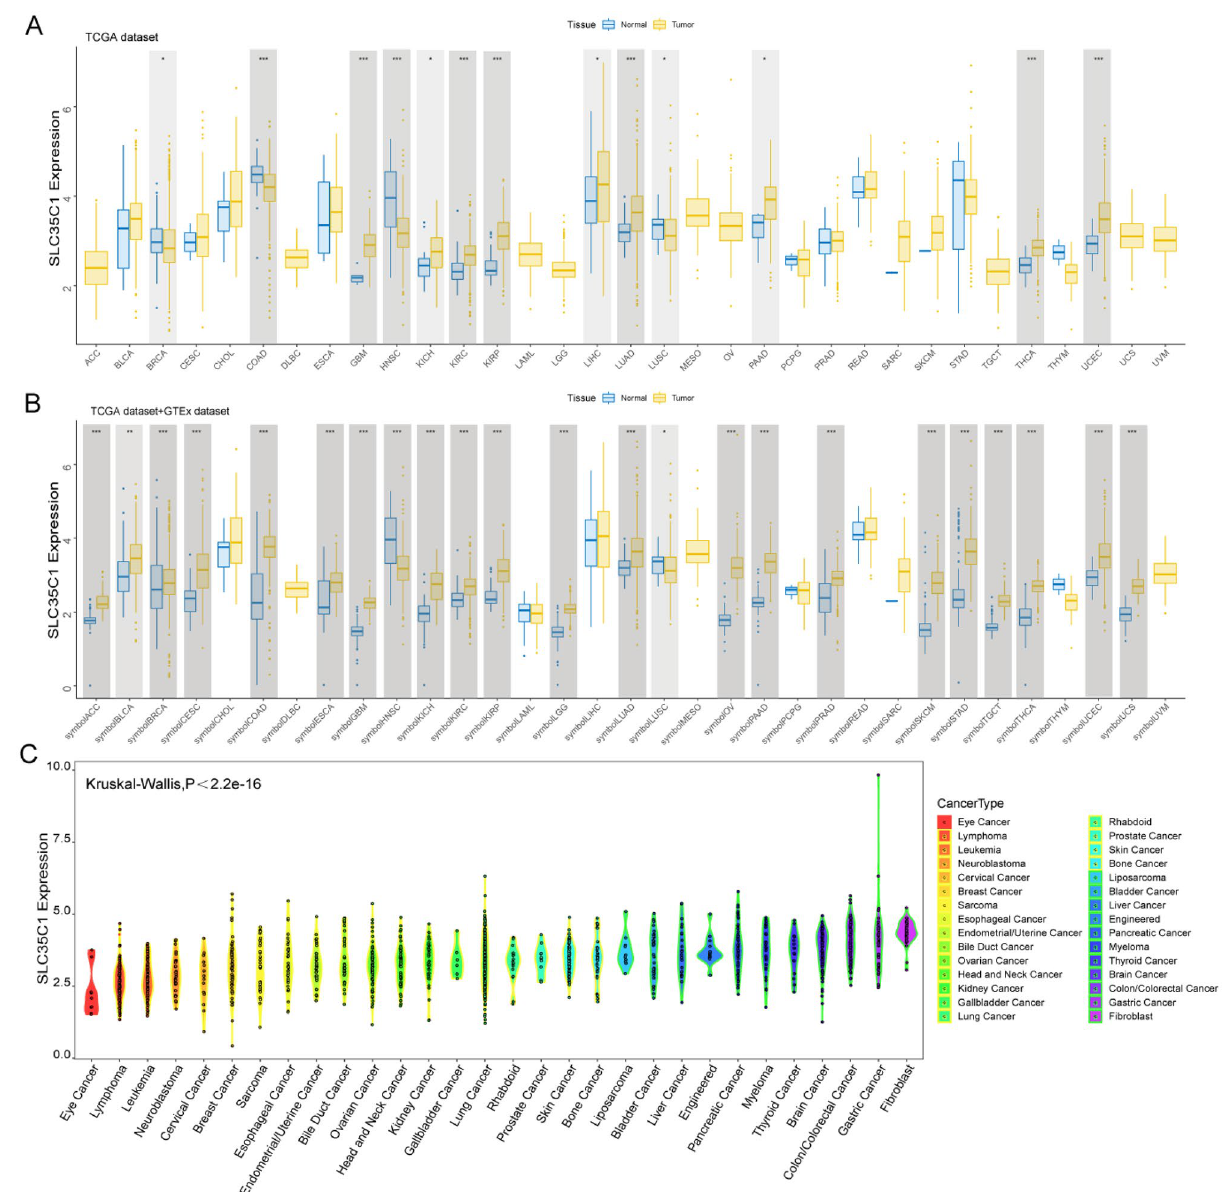
Figure 1. The SLC35C1 expression level in adrenocortical carcinoma (ACC), bladder urothelial carcinoma (BLCA), breast invasive carcinoma (BRCA), Cervical squamous cell carcinoma and endocervical adenocarcinoma (CESC), cholangiocarcinoma (CHOL), colon adenocarcinoma (COAD), Lymphoid Neoplasm Diffuse Large B-cell Lymphoma (DLBC), esophageal carcinoma (ESCA), Glioblastoma multiforme (GBM), head and neck squamous cell carcinoma (HNSC), kidney chromophobe (KICH), kidney renal clear cell carcinoma (KIRC), kidney renal papillary cell carcinoma (KIRP), Acute Myeloid Leukemia (LAML), Brain Lower Grade Glioma (LGG), liver hepatocellular carcinoma (LIHC), lung adenocarcinoma (LUAD), lung squamous cell carcinoma (LUSC), mesothelioma (MESO), Ovarian serous cystadenocarcinoma (OV), pancreatic adenocarcinoma (PAAD), prostate adenocarcinoma (PRAD), rectum adenocarcinoma (READ), Sarcoma (SARC), skin cutaneous melanoma (SKCM), stomach adenocarcinoma (STAD), testicular germ cell tumors (TGCT), Thyroid carcinoma (THCA), Thymoma (THYM), Uterine Corpus Endometrial Carcinoma (UCEC), Uterine Carcinosarcoma (UCS) and uveal melanoma (UVM). ( A ) The mRNA level of SLC35C1 in TCGA. The color refers to the tumor (yellow) or normal (blue), respectively. ( B ) The WASF2 expression level in 33 types from the GTEx database and TCGA database. ( C ) SLC35C1 expression in 30 tumor cells from CCLE database. *P < 0.05; **P < 0.01; ***P <